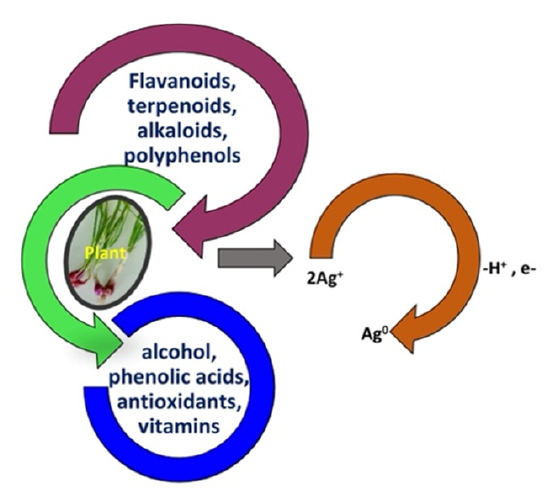
at 445 nm (Abs = 0.9033 A.U.) after 2 Max at 450 nm (Abs = 1.4582 A.U.) within 10 min ( b ). Max